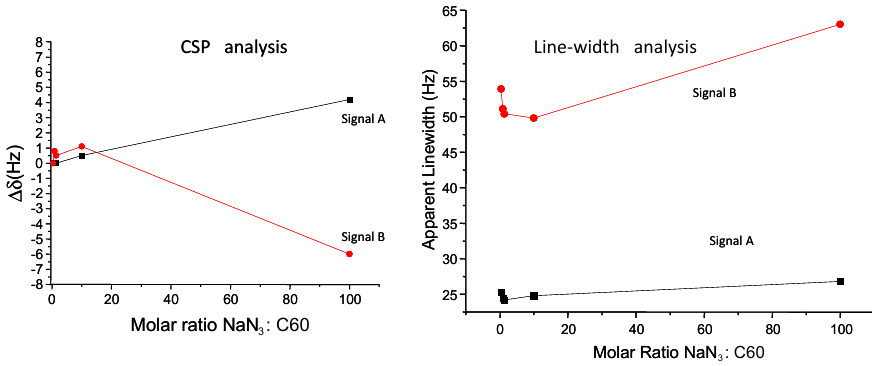
Figure 7. Chemical shift perturbations (CSPs) and line-width study of 14 N peaks of NaN 3 at several molar ratios.